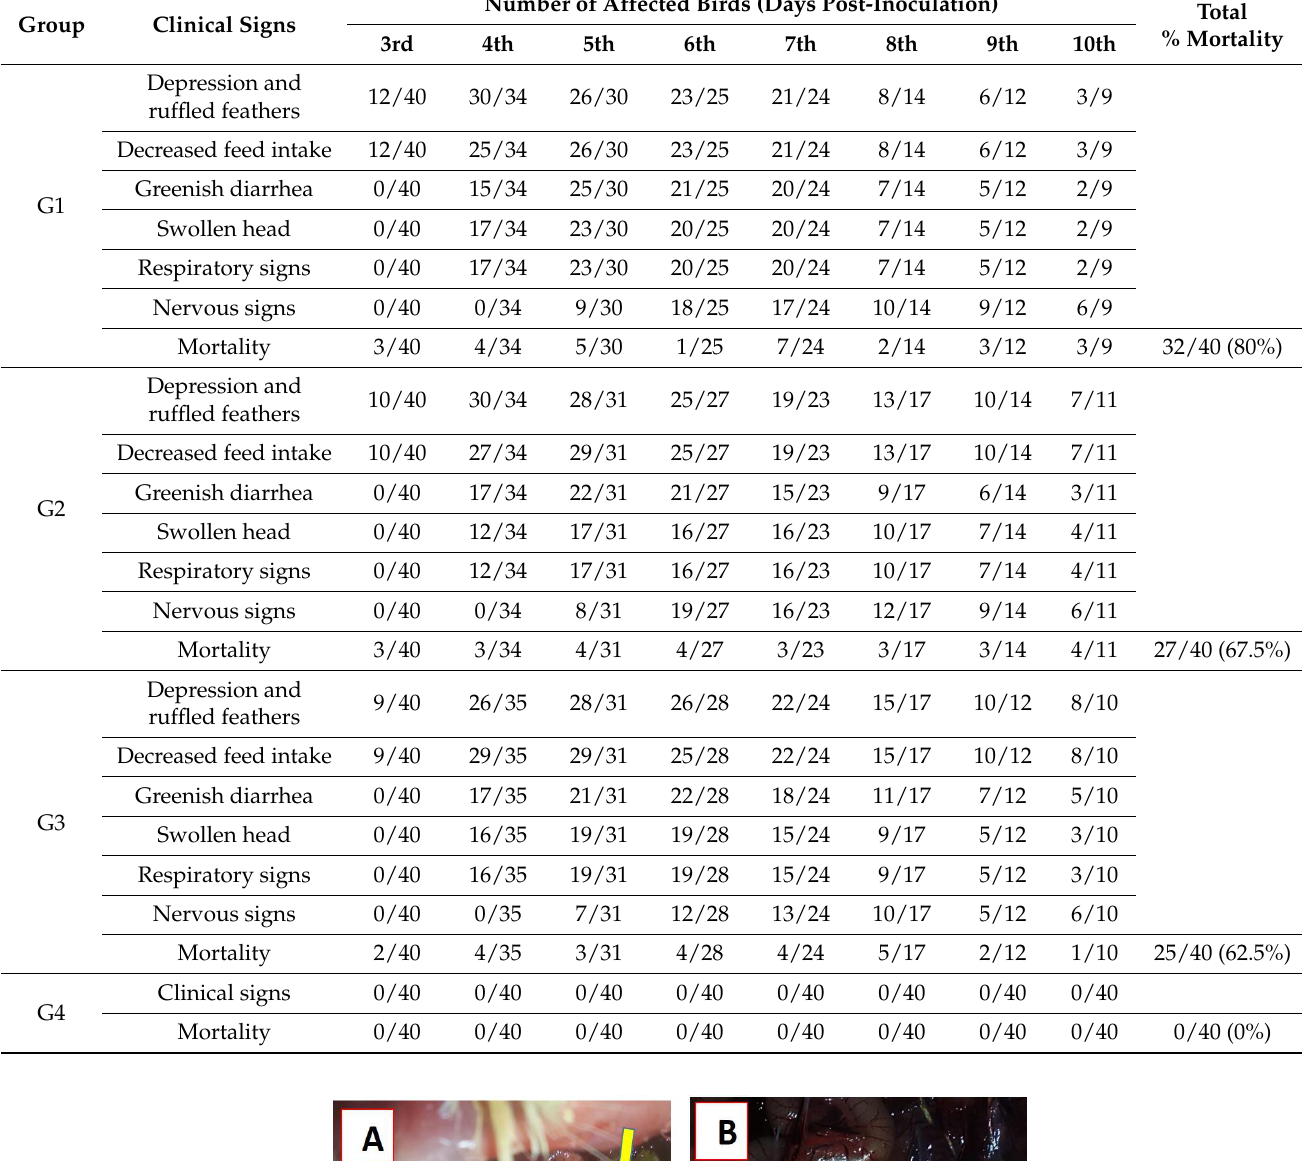
Table 4. Clinical signs appeared in susceptible chickens following pathogenicity testing of sub-genotype VII.1.1 NDV strains originating in wild birds.